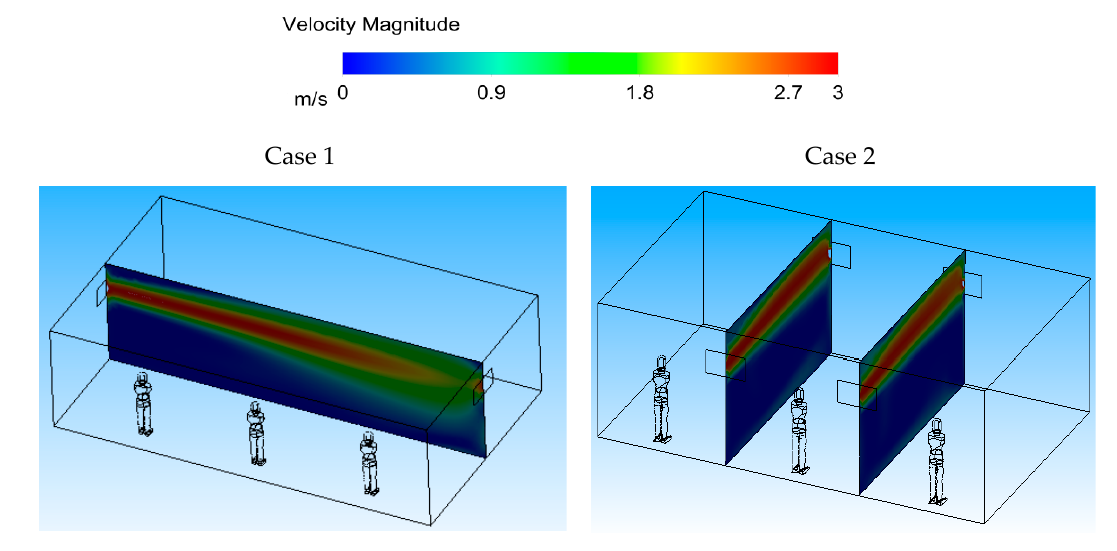
Figure 10. Velocity contours in the middle planes of the space in both cases.